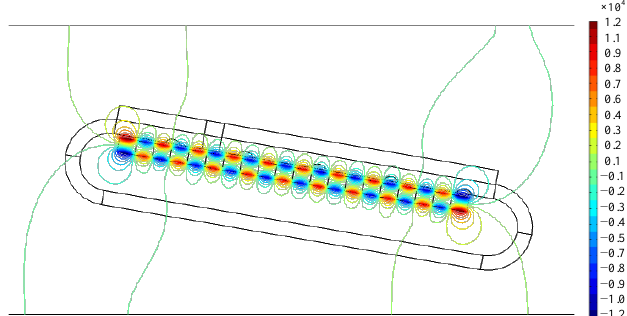
Figure 5. Magnetic field distribution.